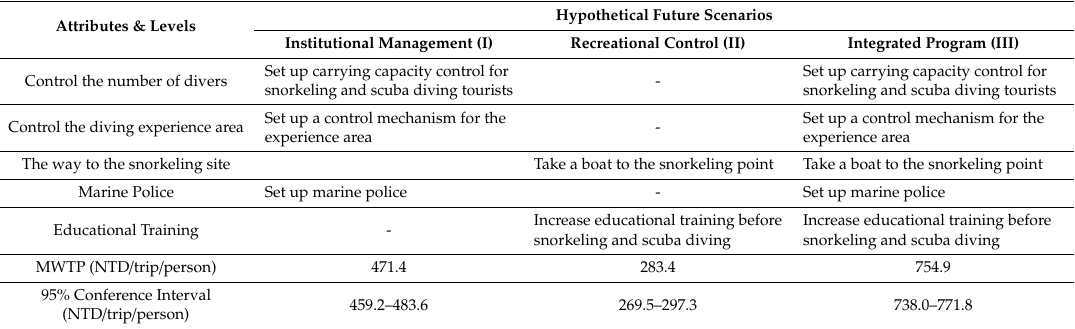
Table 5. The MWTP results for management scenarios under reef impact reduction